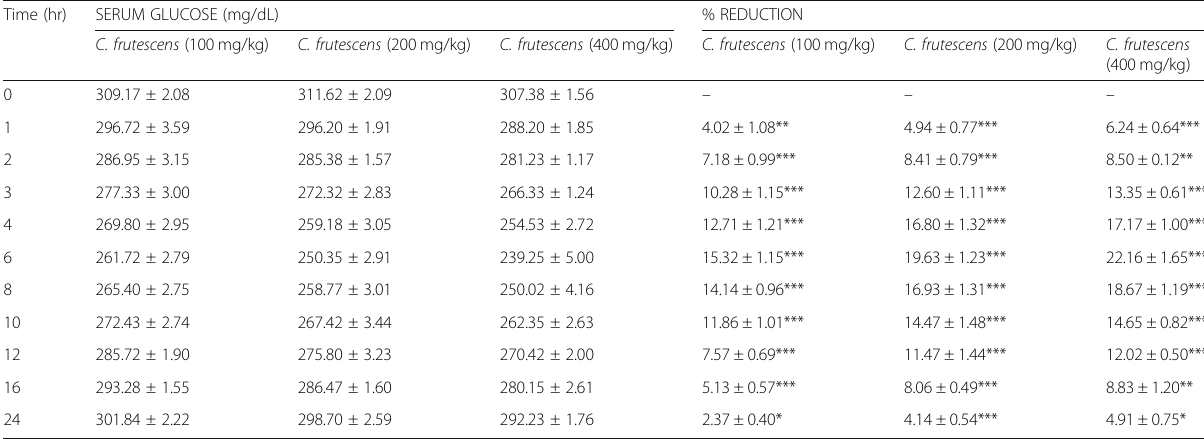
Table 1 Effect of single dose of C. frutescens on serum glucose level and % reduction in diabetic rats Time (hr) SERUM GLUCOSE (mg/dL)